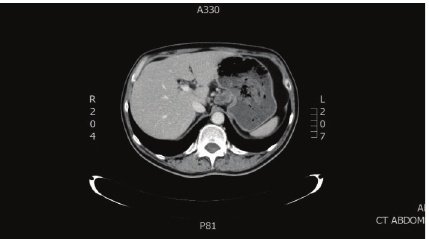
Figure 1: Computed tomography scan (CT) showed a structure of 2.0 × 3.5 cmindiameteronalessergastriccurvaturethatcouldstand for large penetrating ulcer.